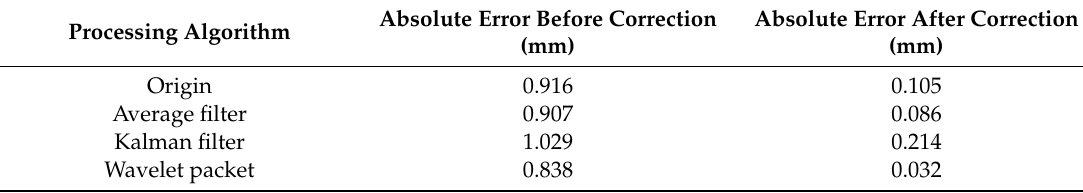
Table 1. Comparison of detection error after signal